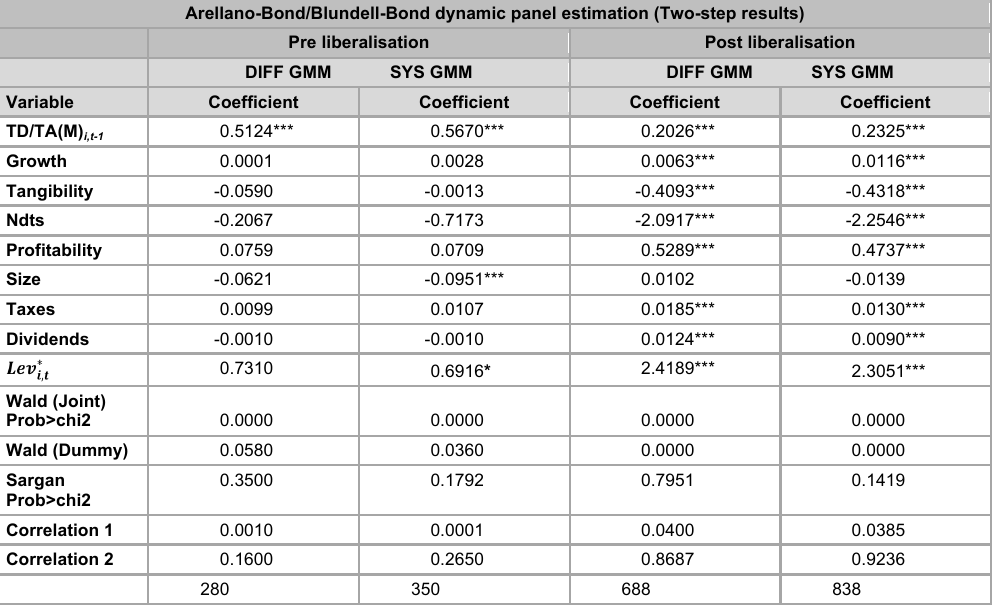
GMM estimates of target capital structure (Market total debt ratio) Arellano-Bond/Blundell-Bond dynamic panel estimation (Two-step